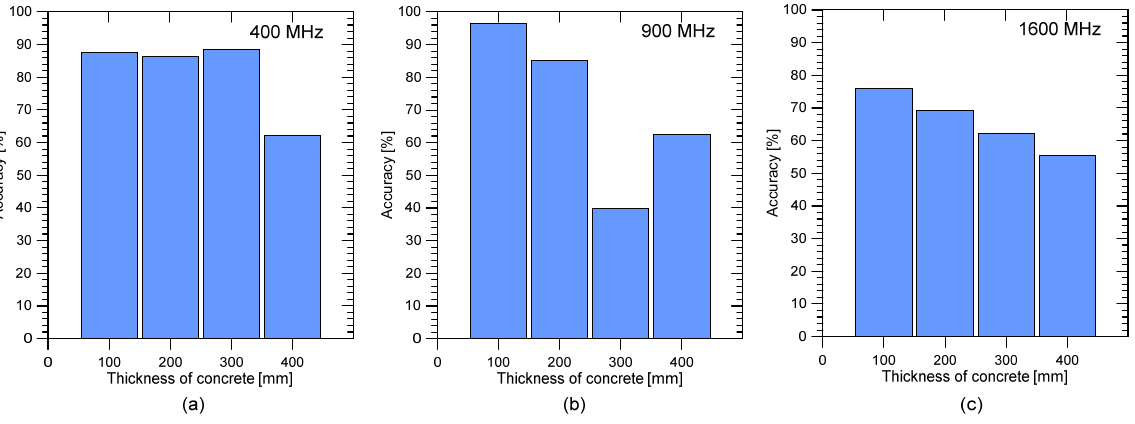
Figure 11. Accuracy of the binary classification model based on cross-correlation coefficient of GPR signals measured on the surface of concrete with various thicknesses ( H c = 100 mm, 200 mm, 300 mm, and 400 mm) by using three GPR antenna frequencies: ( a ) 400 MHz, ( b ) 900 MHz, and ( c ) 1600 MHz.